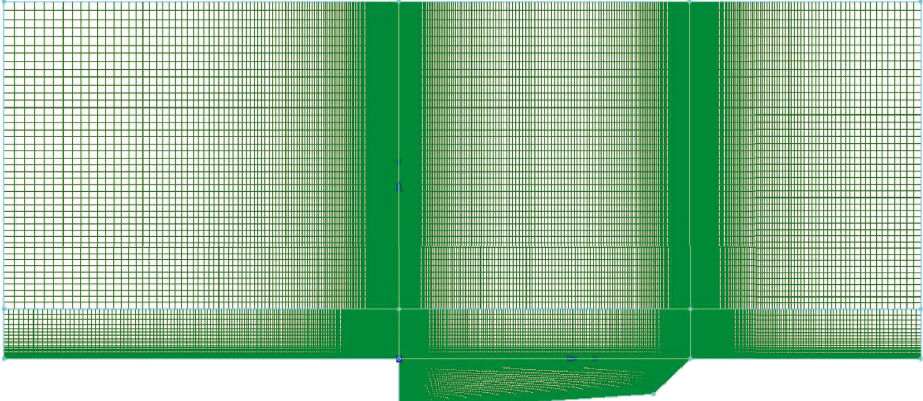
Figure 4: 2D fine grid structure of deformable cavity.